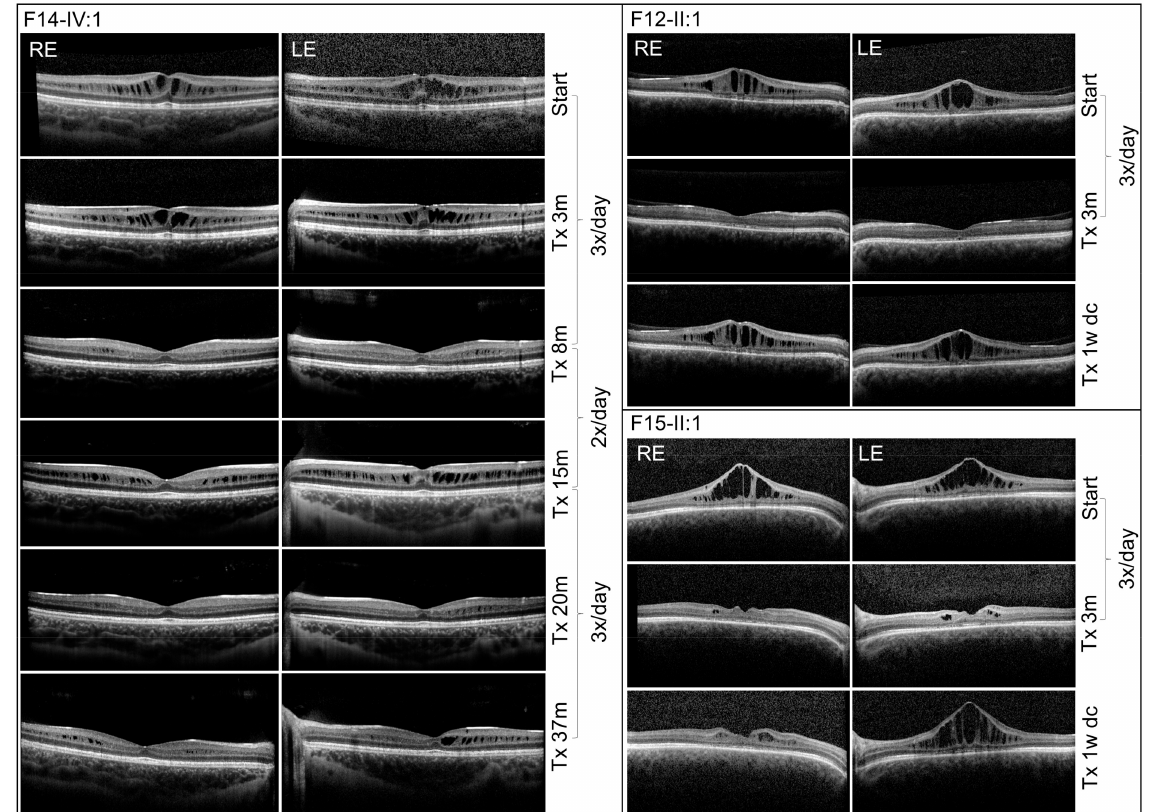
Figure 3. Effects of dorzolamide treatment in three XLRS patients as documented by SD-OCT. Results of individual treatment dosing as well as the length of the therapy are shown. Note rebound phenomena in patient F15-II:1 only after one week of discontinuation of drop administration. dc = discontinued, m = months, Tx = treatment, w =